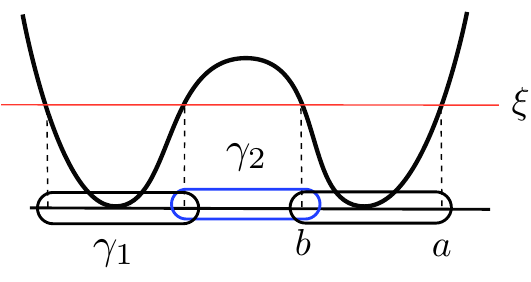
Figure 10 . The symmetric double-well